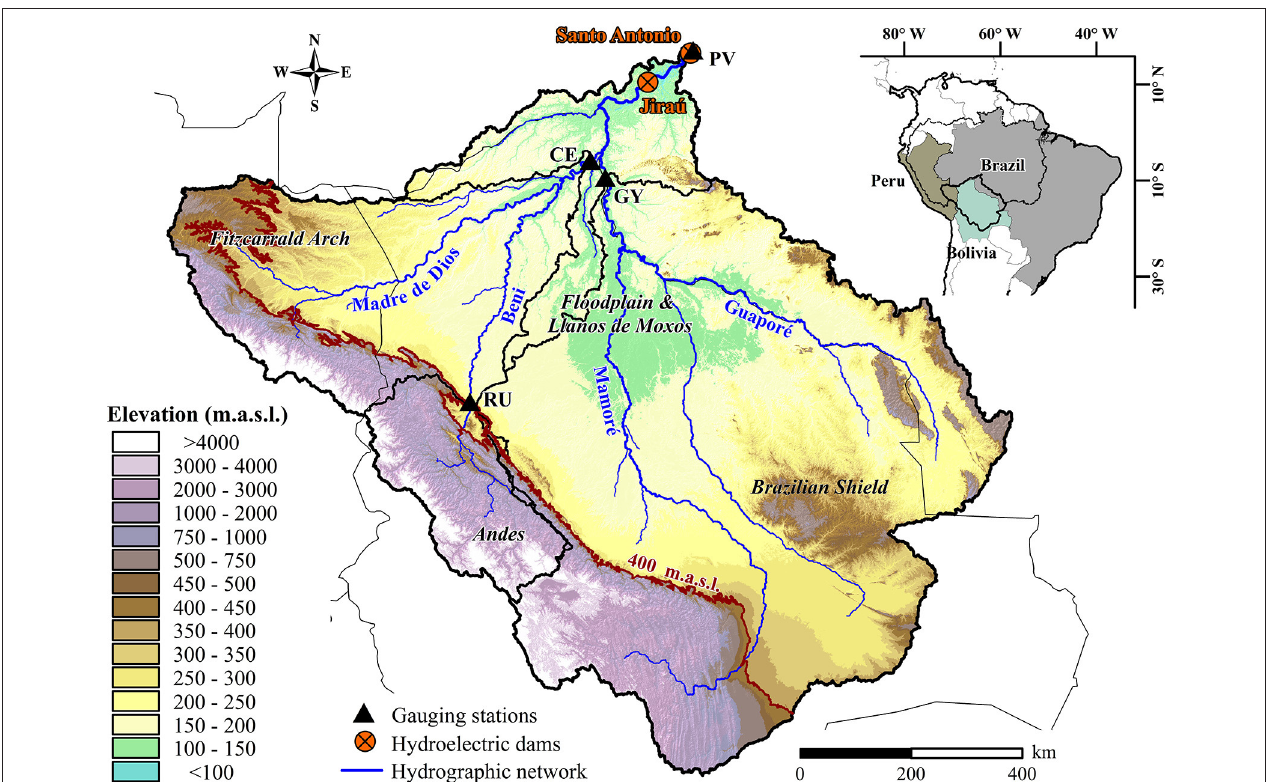
FIGURE 1 | Upper Madeira basin (1 × 10 6 km 2 ) at Porto Velho (PV) outlet gauge station. Cachuela Esperanza (CE) on the Beni River, Rurrenabaque (RU) on the Andean Beni River, and Guayaramerin (GY) on the Mamoré River. Sources: Elevation data from STRM (Farr et al.,